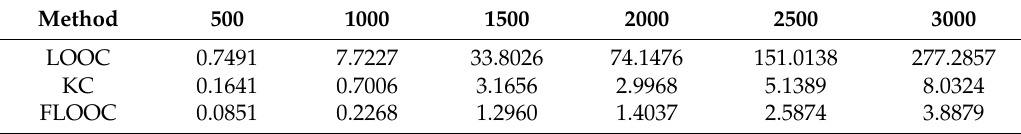
Table 2. The computational efforts of three cross validation method to benchmark dataset “sinc” (s).